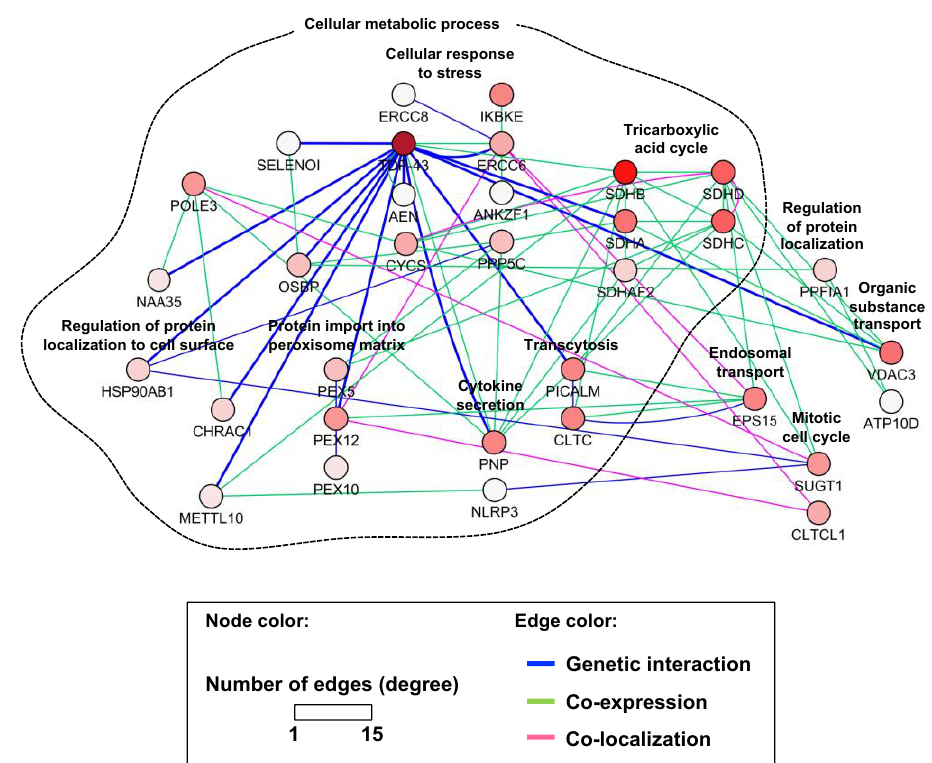
Figure 2. Interaction network of TDP-43 . Human orthologs were identified for 13 yeast genes, the deletions of which suppressed the toxicity of TDP-43. A network view of the genetic interactions between TDP-43 and its interaction loci was generated using the GeneMANIA Cytoscape plugin. Other interacting or associated genes were also included in the network. TDP-43 genetic interactions are highlighted as thick blue lines (edges), and nodes are annotated according to biological processes.